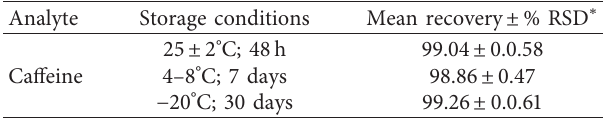
Table 2: Results of solution stability for caffeine.